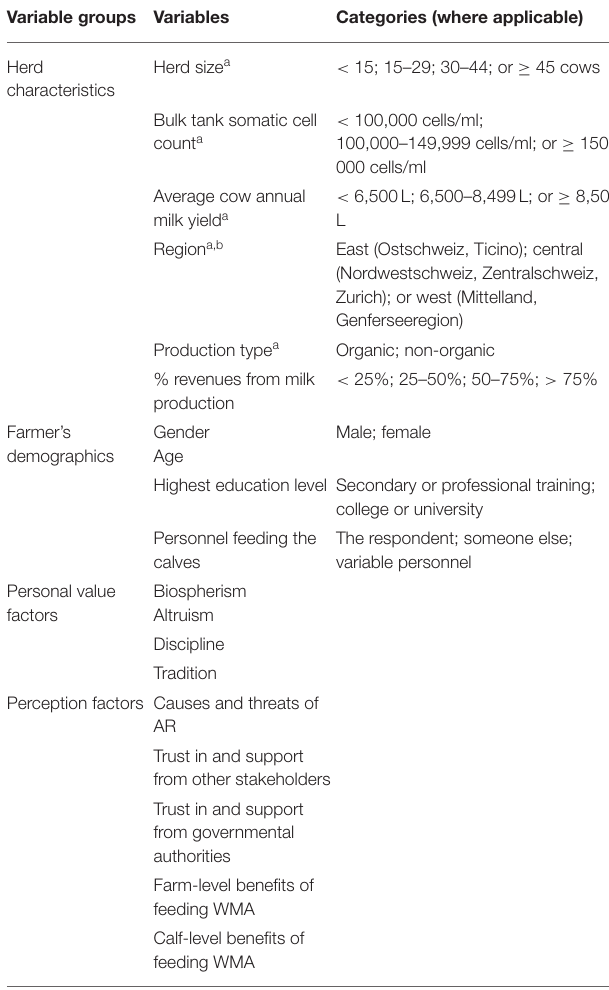
TABLE 2 | Independent variables evaluated for inclusion in the multivariable logistic regression model on the probability of feeding waste milk containing antibiotic residues to calves.